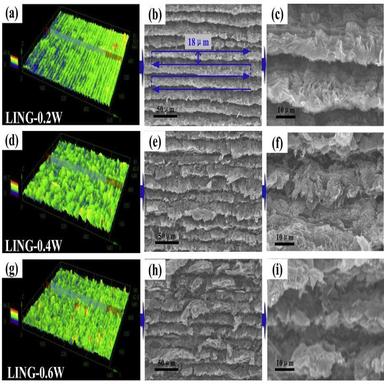
LSCM image (a) and SEM image (b,c) of LING-0.2W. LSCM image (d) and SEM image (e,f) of LING-0.4W. LSCM image (g) and SEM image (h,i) of LING-0.6W. (A colour version of this figure can be viewed online.)